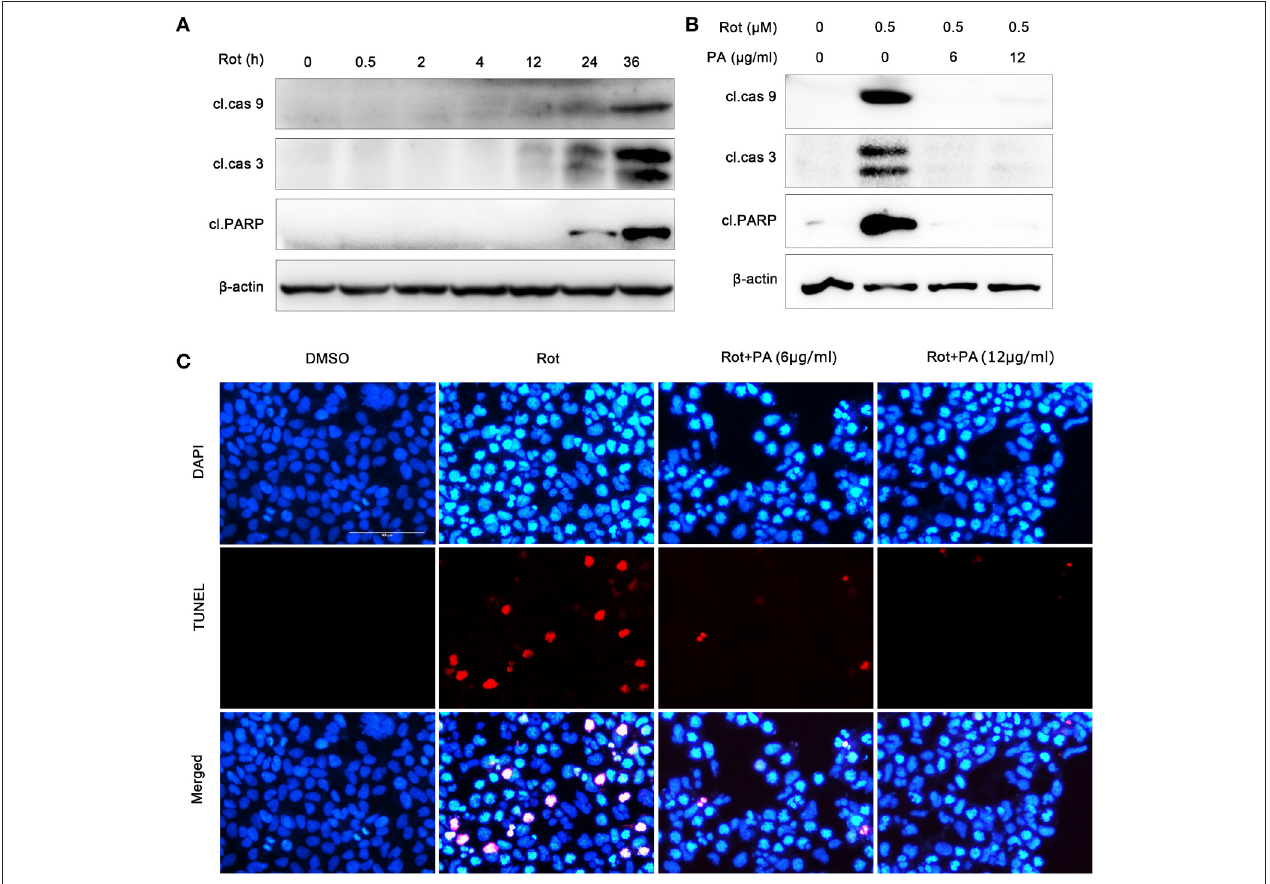
FIGURE 3 | PA protect human neuroblastoma SH-SY5Y cells against rotenone-induced apoptotic cell death. (A) Rotenone induced activation of caspase-9, caspase-3 and cleavage of PARP in 24 and 36h. Samples were assessed by western blot with antibody against the cleaved caspase-9, caspase-3 and PARP, and β -actin was used as loading control. (B) PA reduced the activation of caspase-9, caspase-3 and cleavage of PARP induced by rotenone. Cells were treated with rotenone or rotenone plus PA (6 or 12 µ g) for 36h. Samples were assessed by western blot with antibody against the cleaved caspase-9, caspase-3 and PARP, and β -actin was used as loading control. (C) SH-SY5Y cells were treated with rotenone or rotenone plus PA (6 or 12 µ g) for 36h, and then apoptosis was detected by TUNEL (red) staining, nuclei were stained by DAPI (blue). Scale bar: 100 µ m. Results are representative of at least three